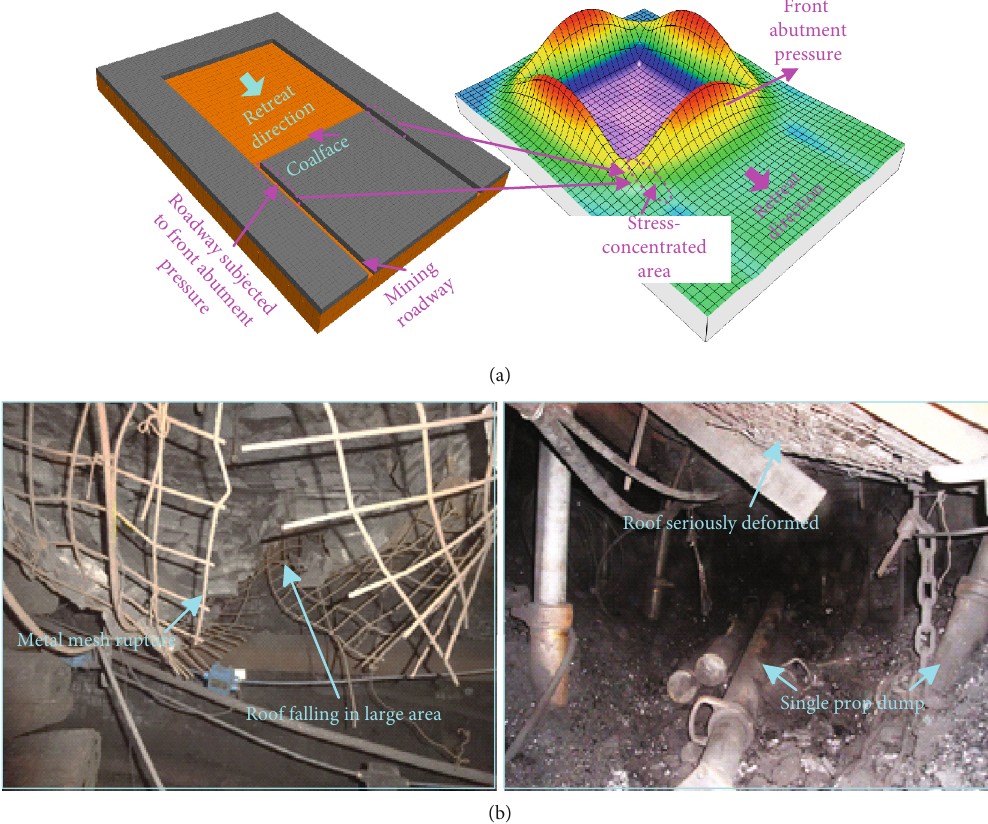
Figure 1: Stress distribution and roof falling disaster in the roadway subjected to the dynamic abutment pressure: (a) stress distribution characteristics; (b) roof falling